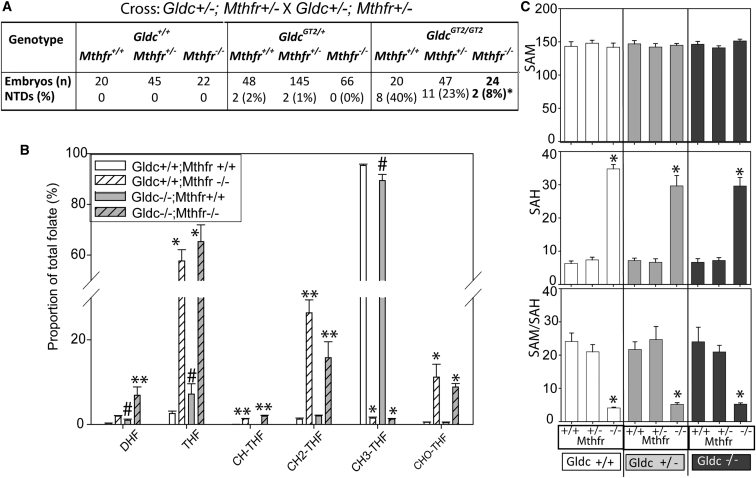
Prevention of Gldc-Associated NTDs by Mthfr Loss of Function(A) The frequency of NTDs among Gldc homozygous mutants is significantly affected by Mthfr genotype (different from Mthfr+/+, ∗p < 0.05 Fisher’s exact test).(B) Among embryos carrying loss-of-function alleles of Gldc and Mthfr (n = 4–7 samples per genotype at E11.5), we observed significant variation between genotypes in the relative abundance of each folate (p < 0001, ANOVA; Holm-Sidak pairwise comparison: ∗∗ indicates difference to all other genotypes, ∗ bars do not differ from each other but significantly differ from all other genotypes; # indicates significant difference with Gldc genotype in Mthfr+/+ embryos).(C) Abundance of SAH was significantly increased and the SAM/SAH ratio decreased in all Mthfr−/−embryos compared with other Mthfr genotypes, irrespective of Gldc genotype (∗p < 0.01, ANOVA).